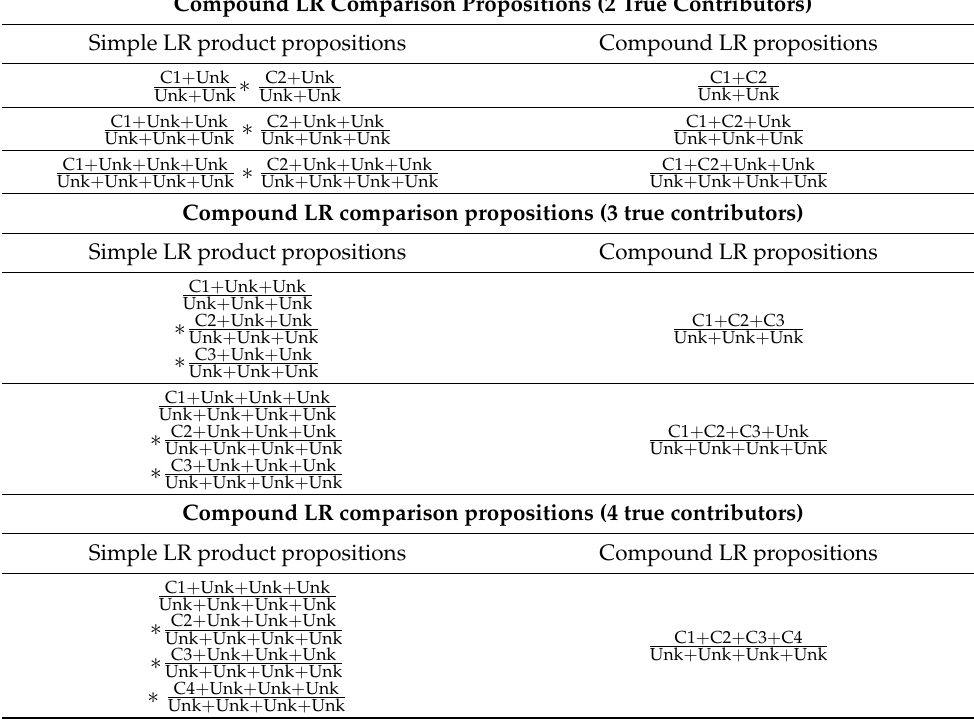
Table 3. Propositions for simple LR product v. compound LR comparisons. Note that the designations “C1”, “C2”, etc. are generic and represent more than one combination of mixture contributors. For instance, under “Two true contributors”, C1 and C2 in proposition set (2) represent the three different combinations of two true contributors in a three-person mixture that could be paired